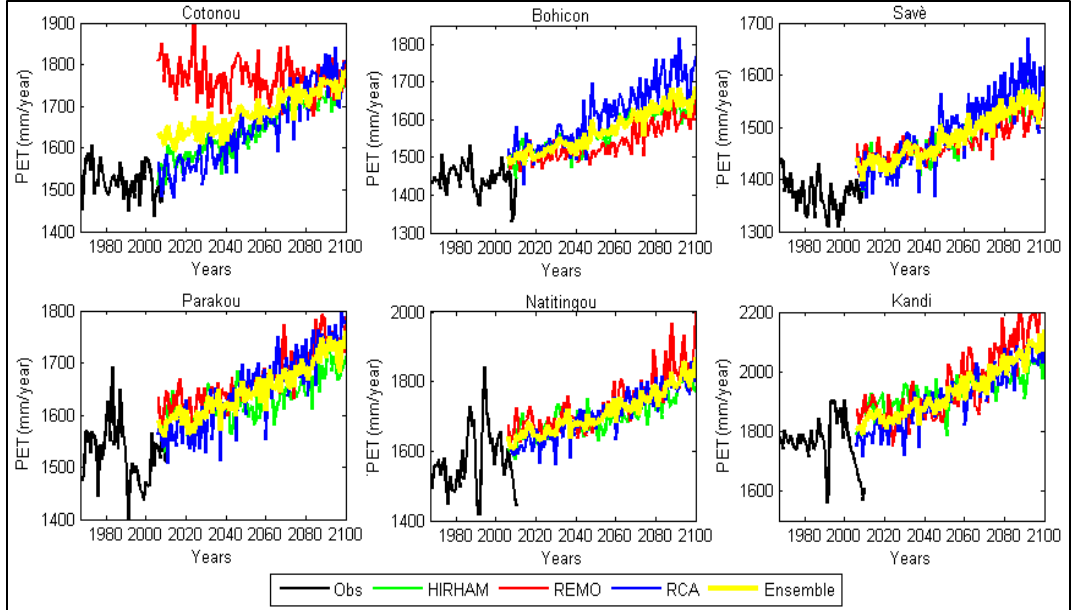
Figure 6. Evolution of annual PET from 1967 to 2100 under RCP8.5 scenario.